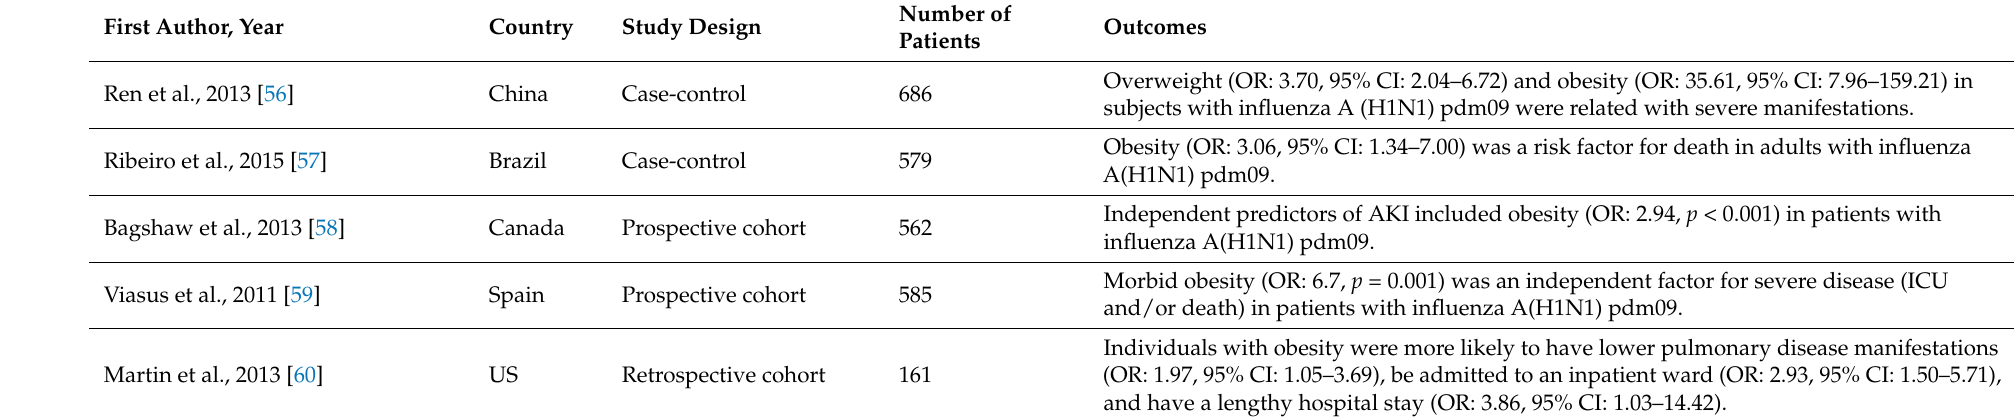
Table 3. Summary of studies on prognosis of influenza and